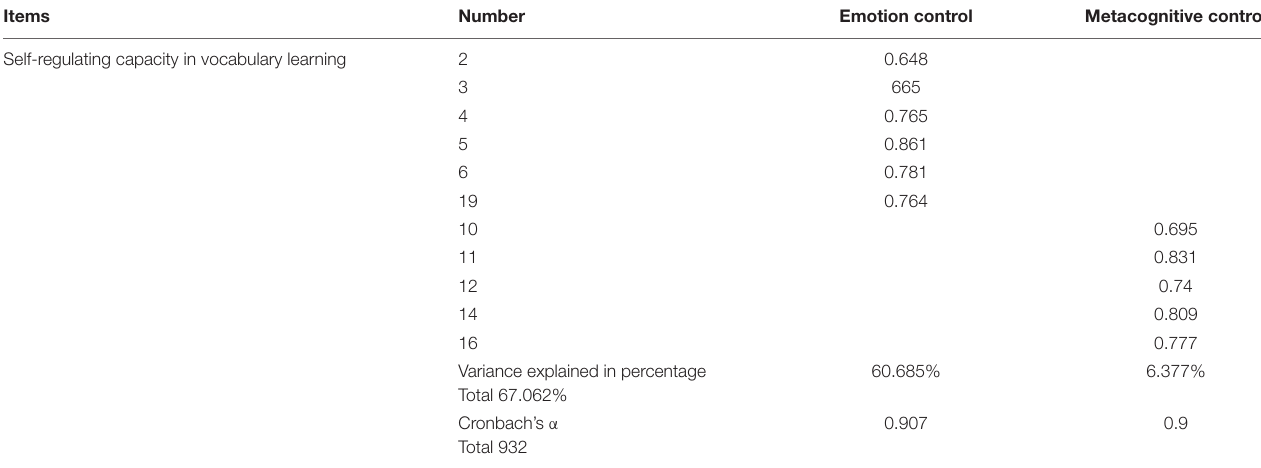
TABLE 1 | Factors extracted from exploratory factor analysis (EFA). Items